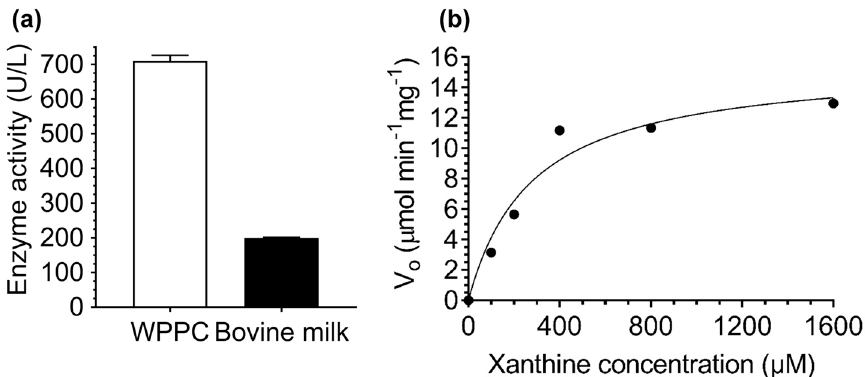
Figure 6. ( a ) Xanthine oxidase activity of whey protein phospholipid concentrate (WPPC) (sample 6B) and bovine milk, and ( b ) Michaelis–Menten kinetics of whey protein phospholipid concentrate (WPPC) xanthine oxidase for uric acid generation. For the graph, the corresponding fits (solid lines) Km, and Vmax data were obtained using the Michaelis–Menten equation.